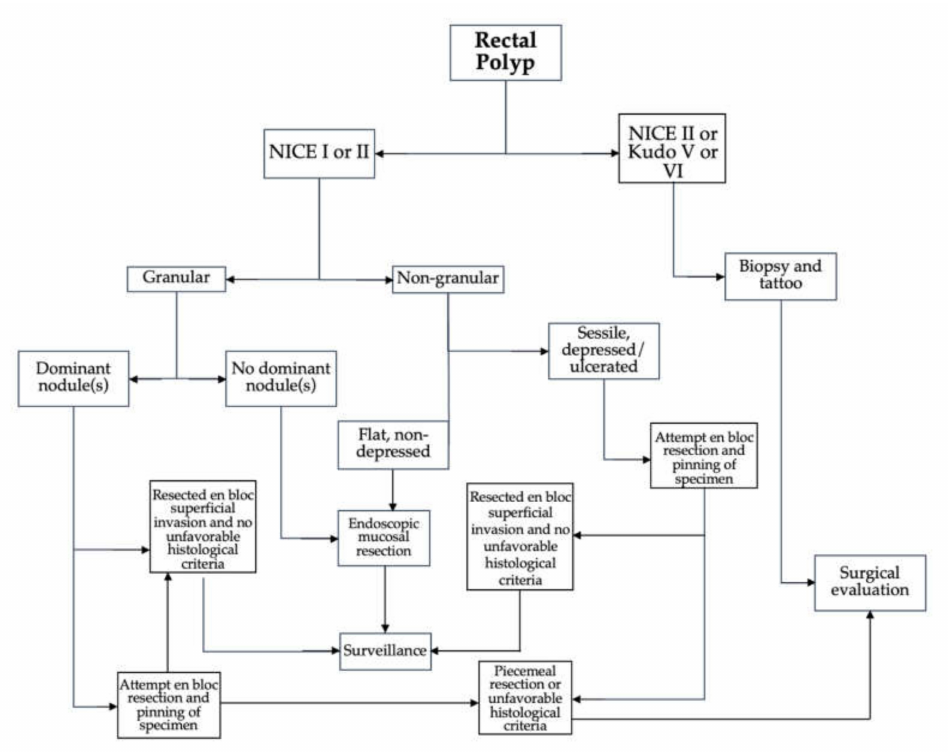
Figure 1. Algorithm for approach to rectal polyp assessment and